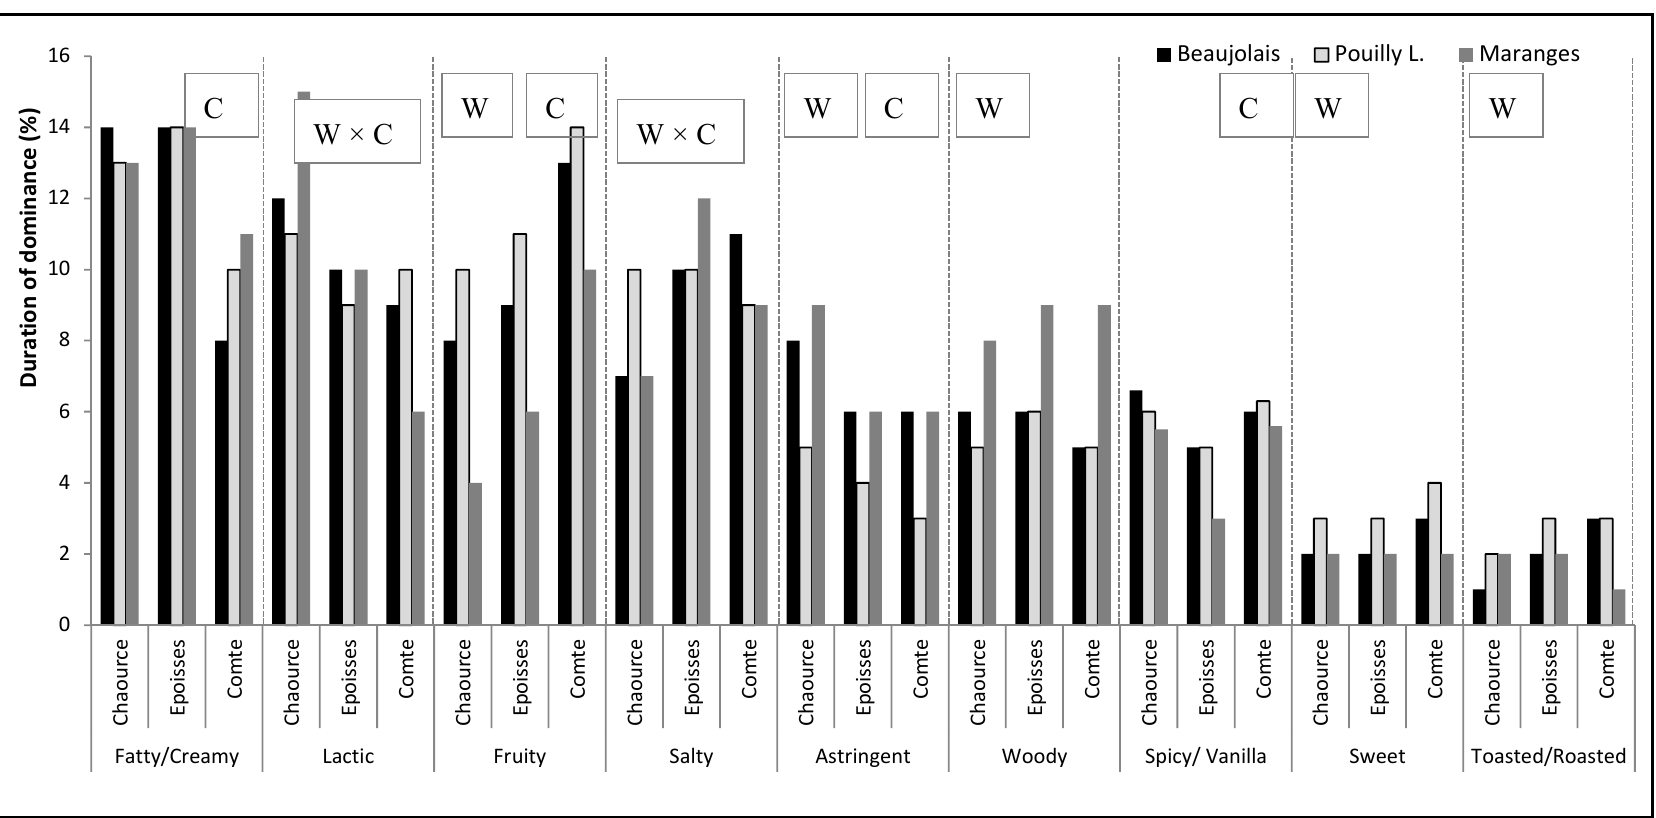
Figure 3. Standardized duration of dominance (%) by descriptor by combination. W = significant wine effect ( p < 0.1); C = significant cheese effect ( p < 0.1); W × C = significant interaction ( p < 0.1).